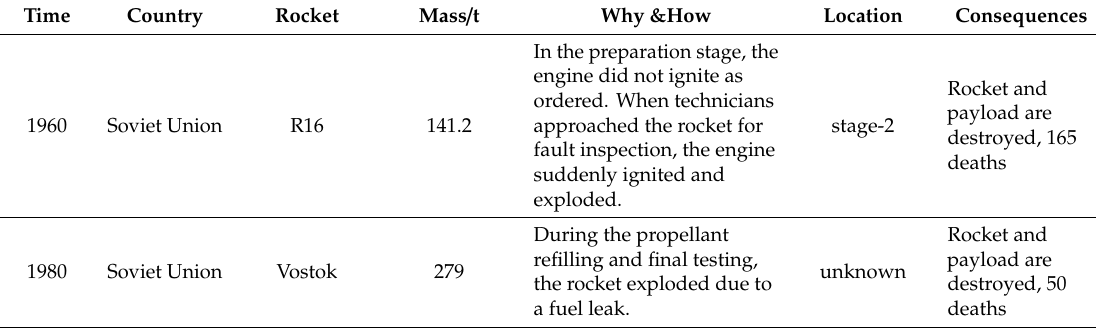
Table 1. Typical accident statistics of rocket explosion on launch